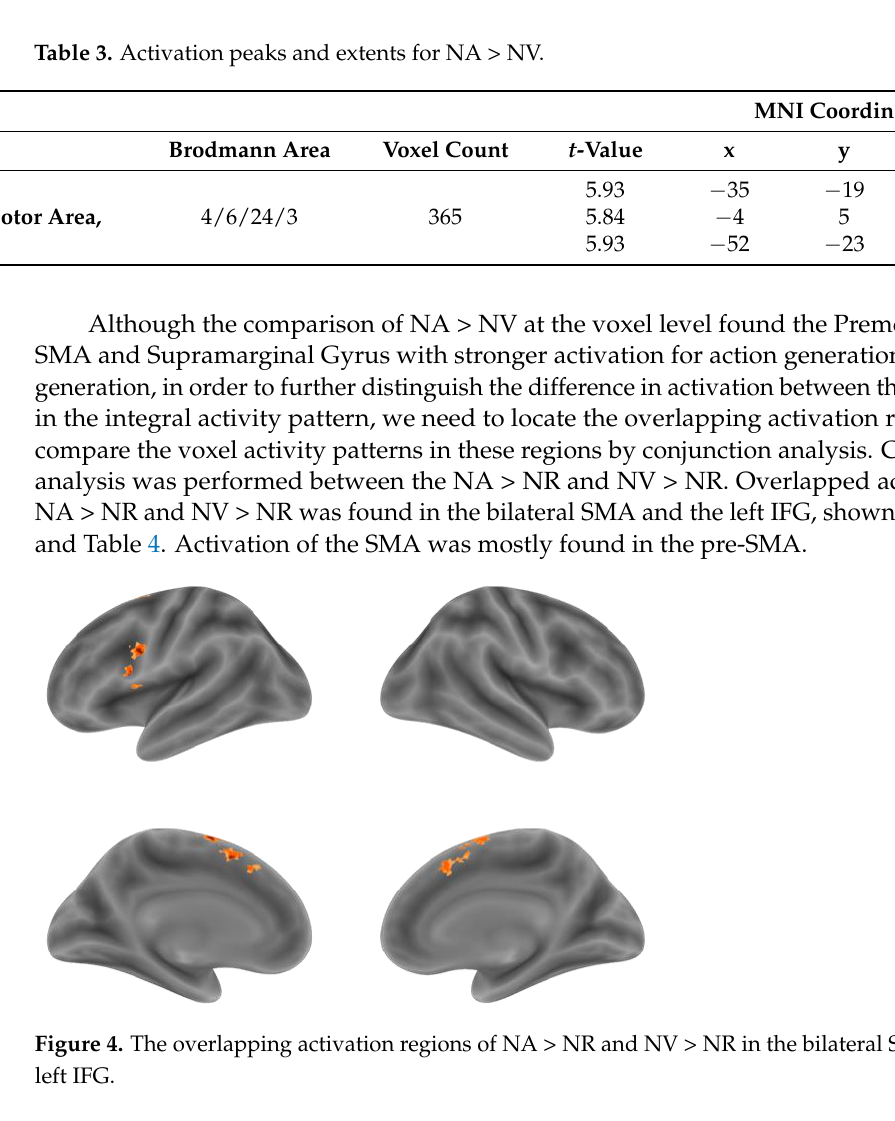
Table 3. Activation peaks and extents for NA > NV.